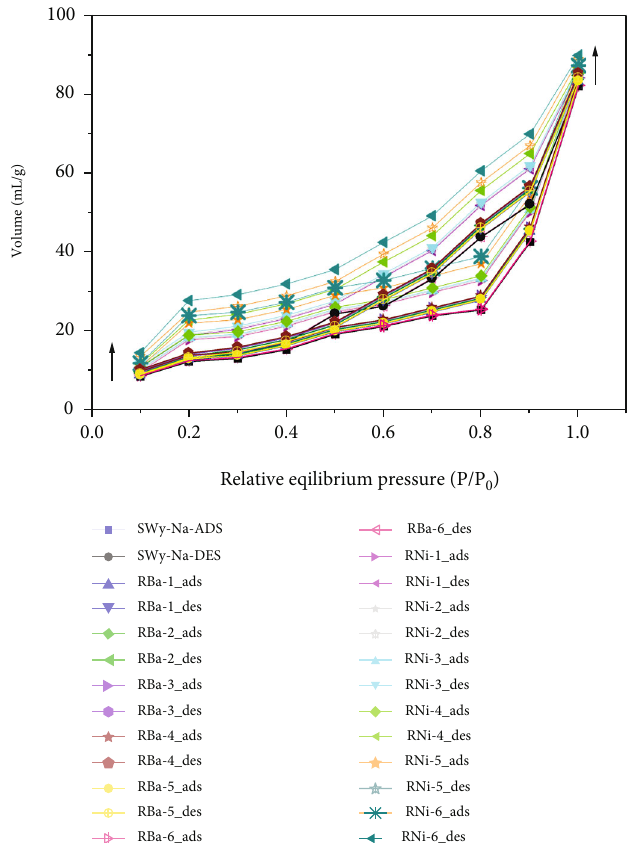
Figure 7: Nitrogen adsorption- (ads-) desorption (des)